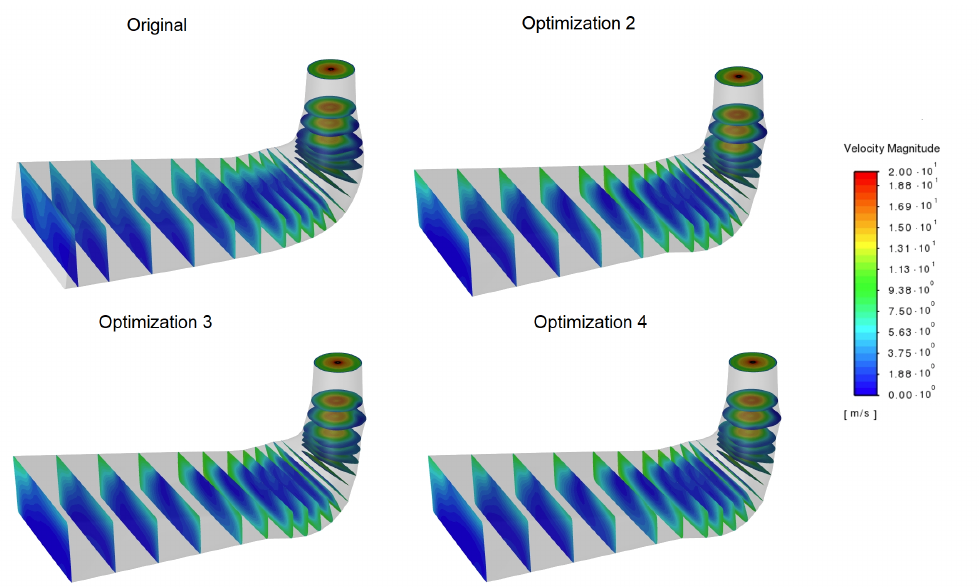
Figure A3. Velocity magnitudes in several draft tube cross-sections for a 10 m 3 /s flow